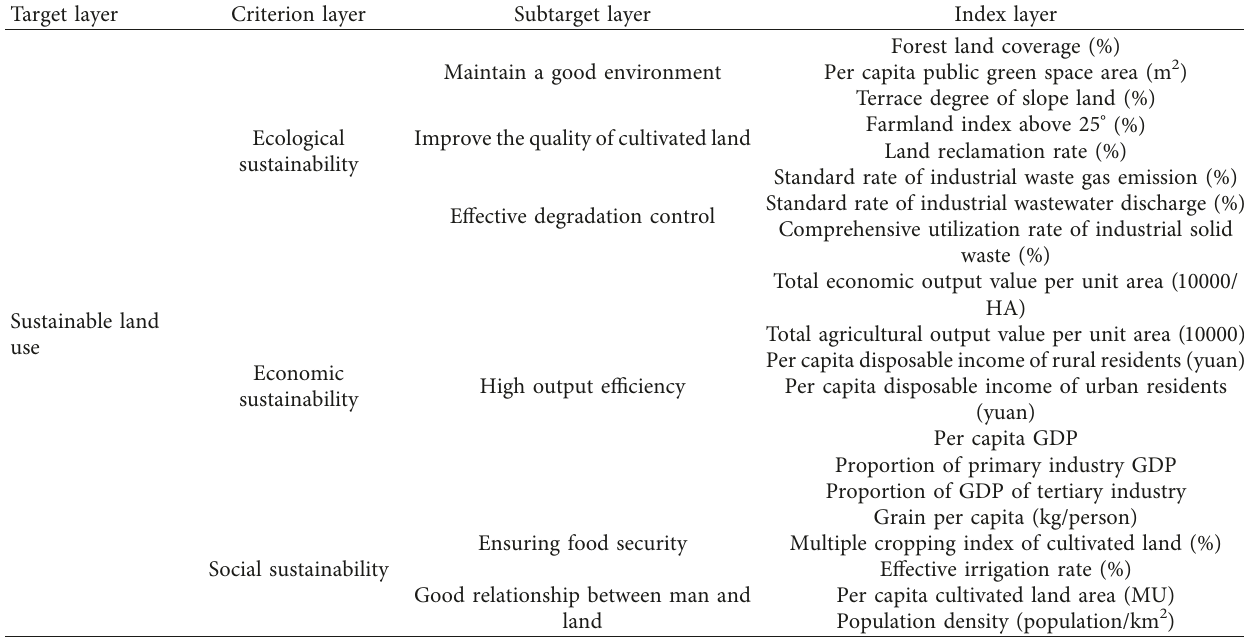
Table 1: Evaluation index